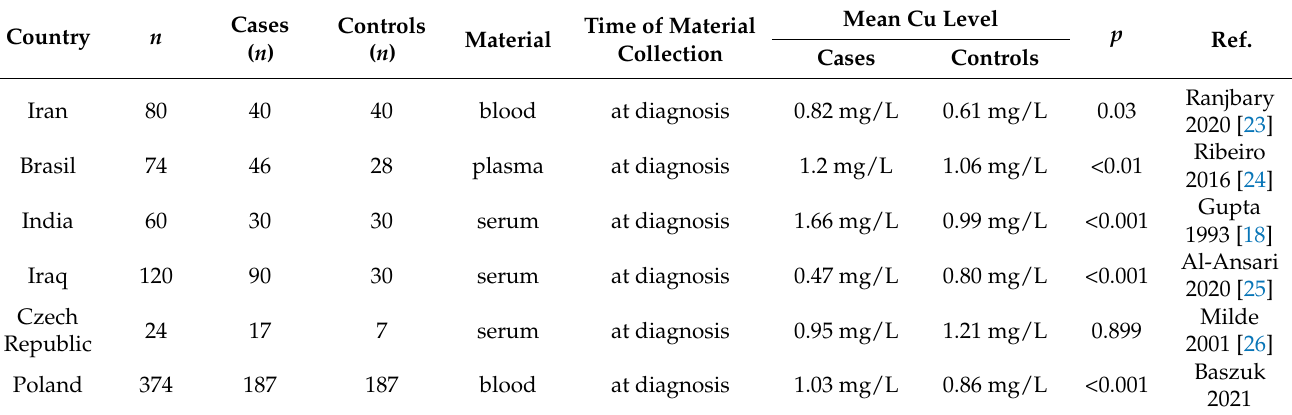
Table 15. Case-control studies on the association between copper level and occurrence of colorectal